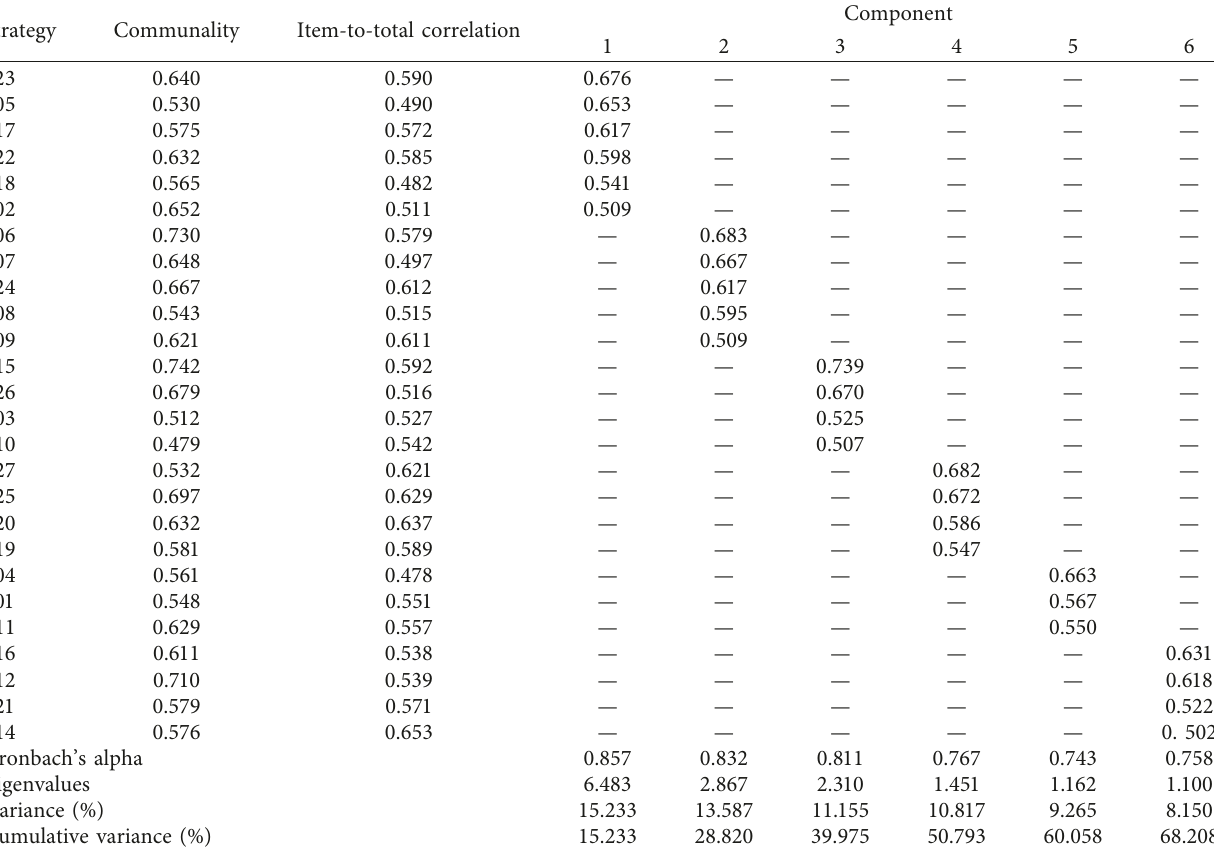
Table 4: Results of the exploratory factor analysis.